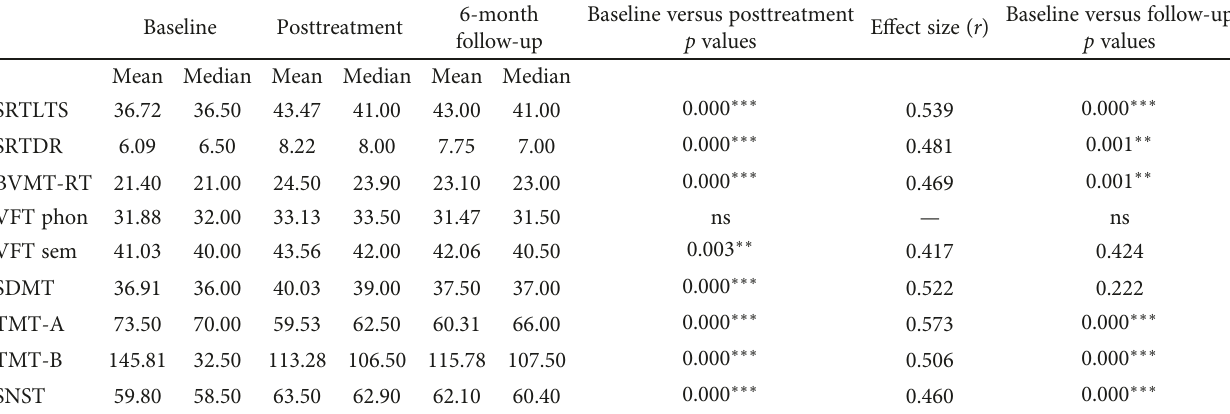
Table 4: Comparison of neuropsychological test scores for the RehaCom MS-treated group at baseline, posttreatment, and at 6-month follow-up. Baseline Posttreatment